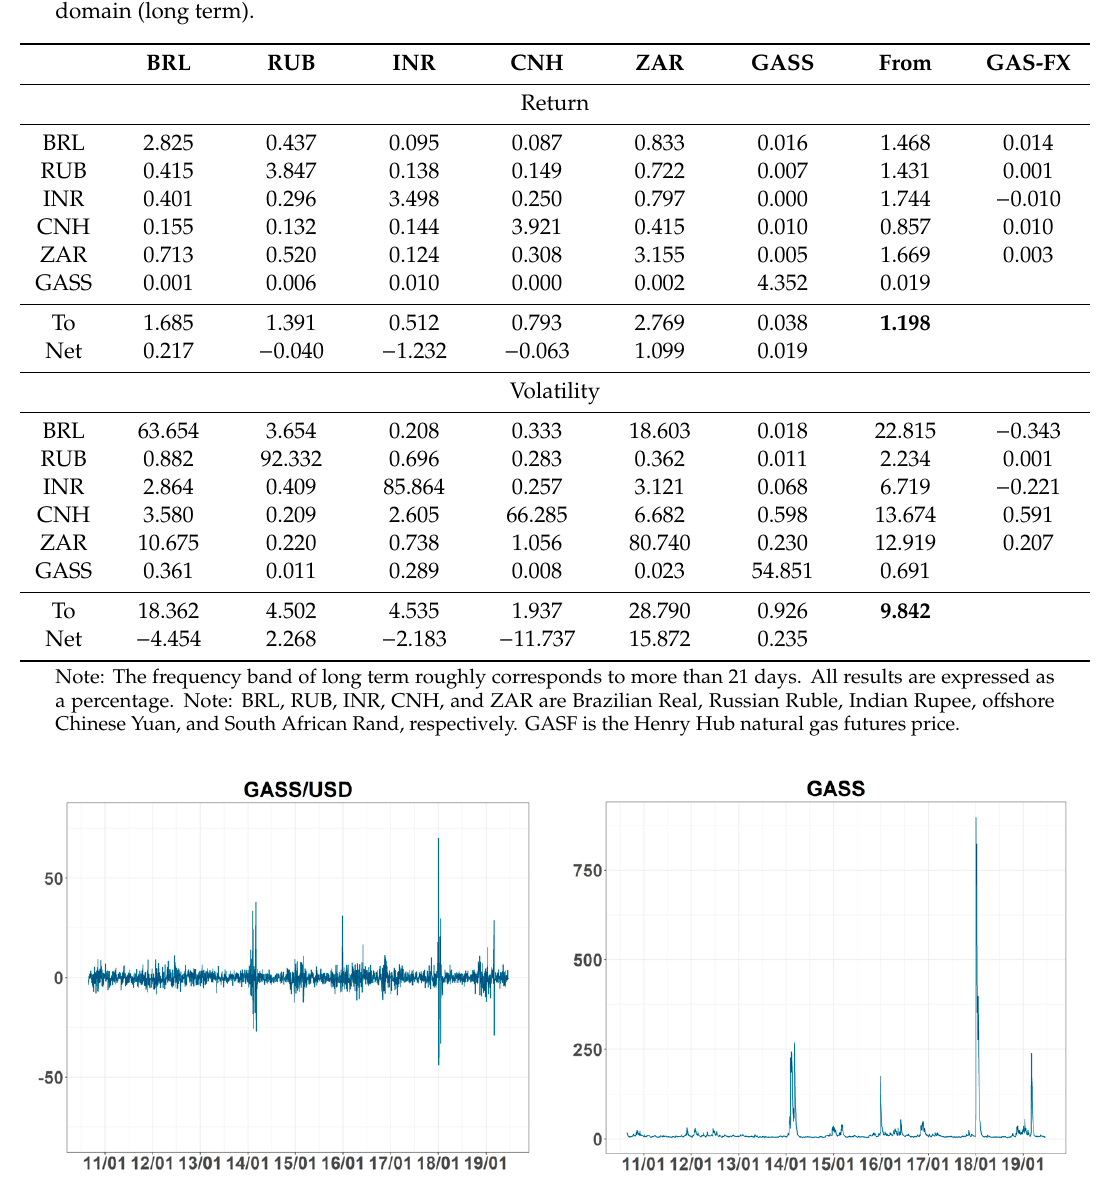
Table A5. Connectedness between the natural gas spot price and exchange rates in the frequency domain (long term).